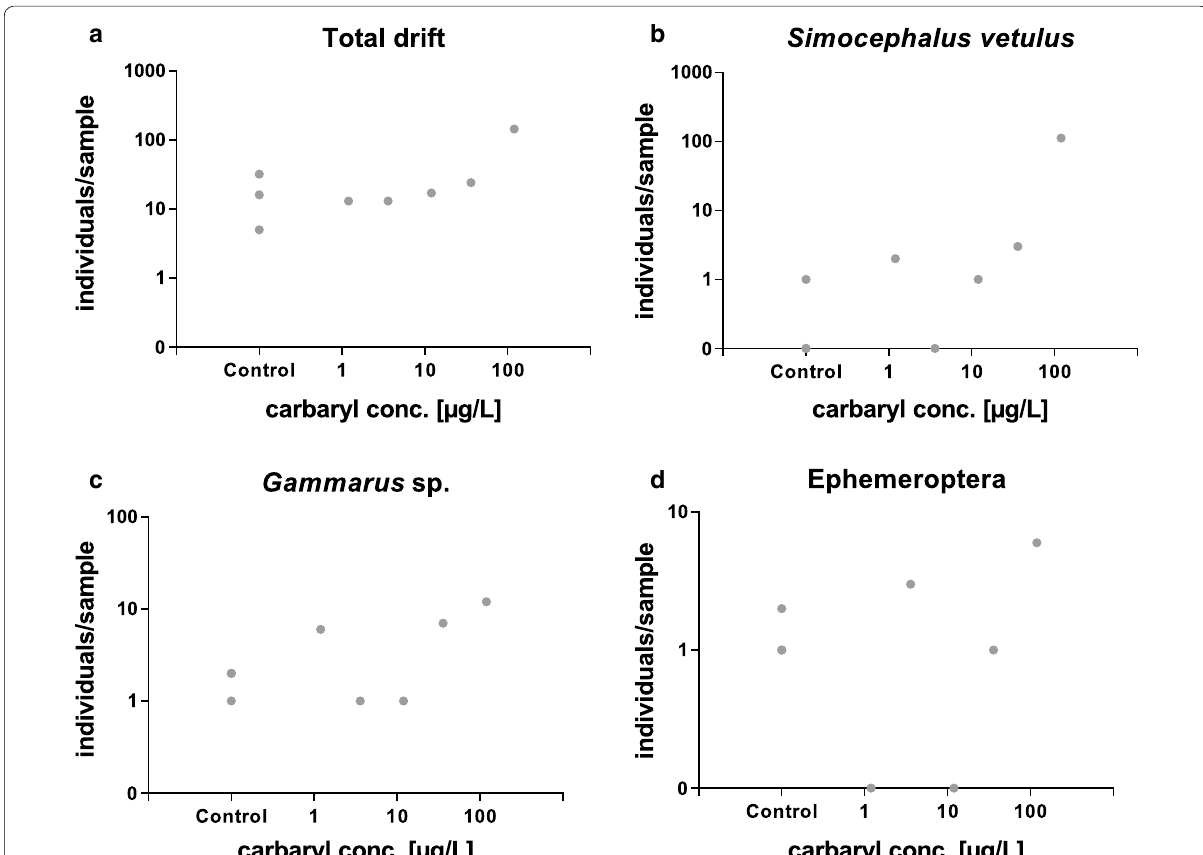
Fig. 7 Invertebrate drift at different carbaryl concentrations 4 h after application. a Total drift, b number of d Simocephalus vetulus , c Gammarus sp. and d the order Ephemeroptera